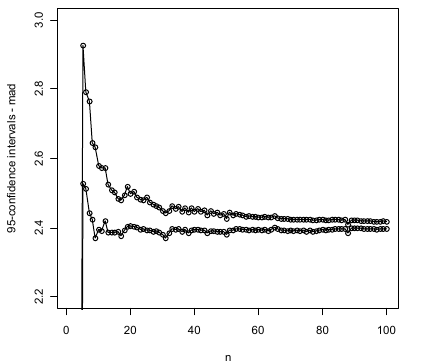
Figure 13 – The same of figure 12: upper limit minus lower limit of 95% confidence